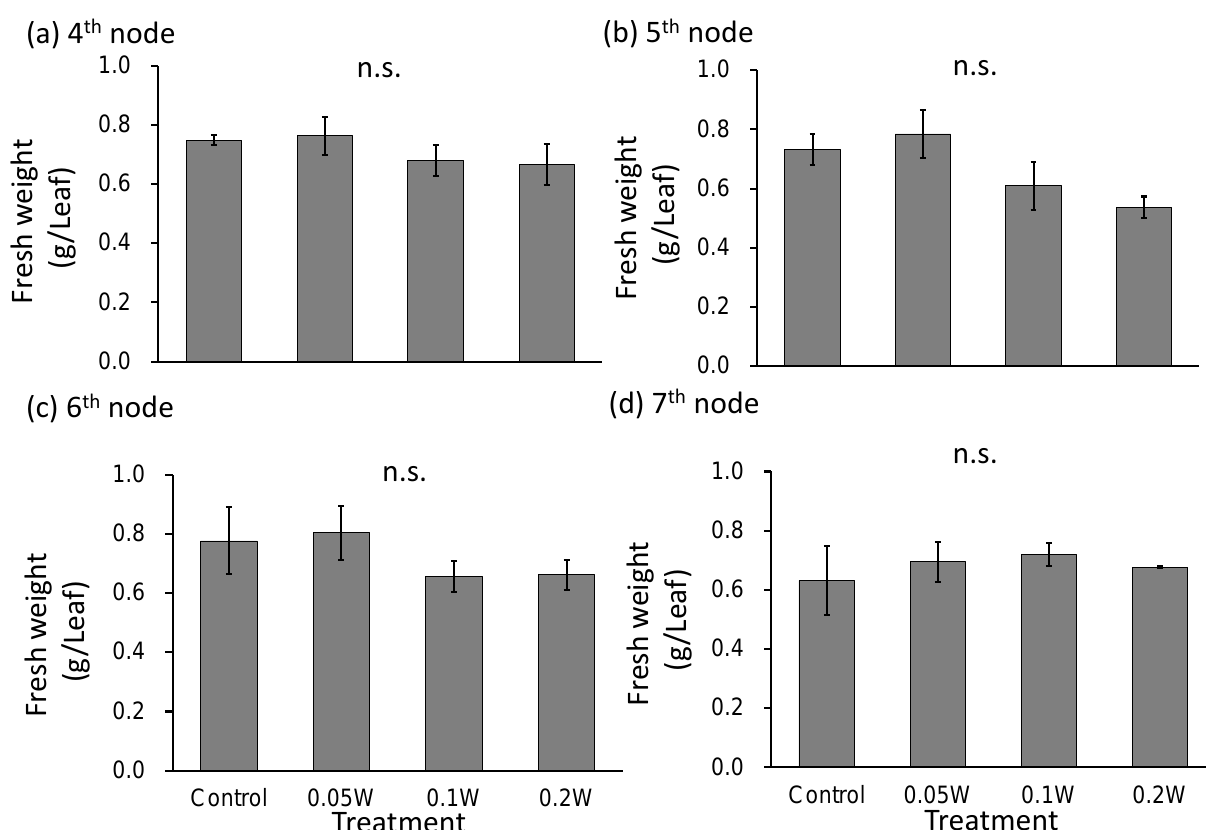
Figure 4. Effect of exposure to 3 h of nocturnal UV-B lighting on leaf fresh weight of red perilla plants (Experiment 2). Perilla plants were irradiated for 3 h from 02:00 to 05:00 in all UV-B light treatments. The UV-B radiation intensity at the plant canopy level was set to 0.05, 0.1, or 0.2 W m − 2 . The integrated UV-B energy at 0.05, 0.1, and 0.2 W m − 2 was 0.54, 1.0 and 2.2 kJ m − 2 day − 1 , respectively. Leaves at the 4th node counted from the bottom of the main stem were harvested 1 week after treatment initiation; thereafter, leaves at 5th, 6th, and 7th nodes were sampled from the same plants at 2, 3, and 4 weeks after treatment initiation. Vertical bars indicate SE ( n = 4). n.s. indicates no significant difference as per the Tukey-Kramer